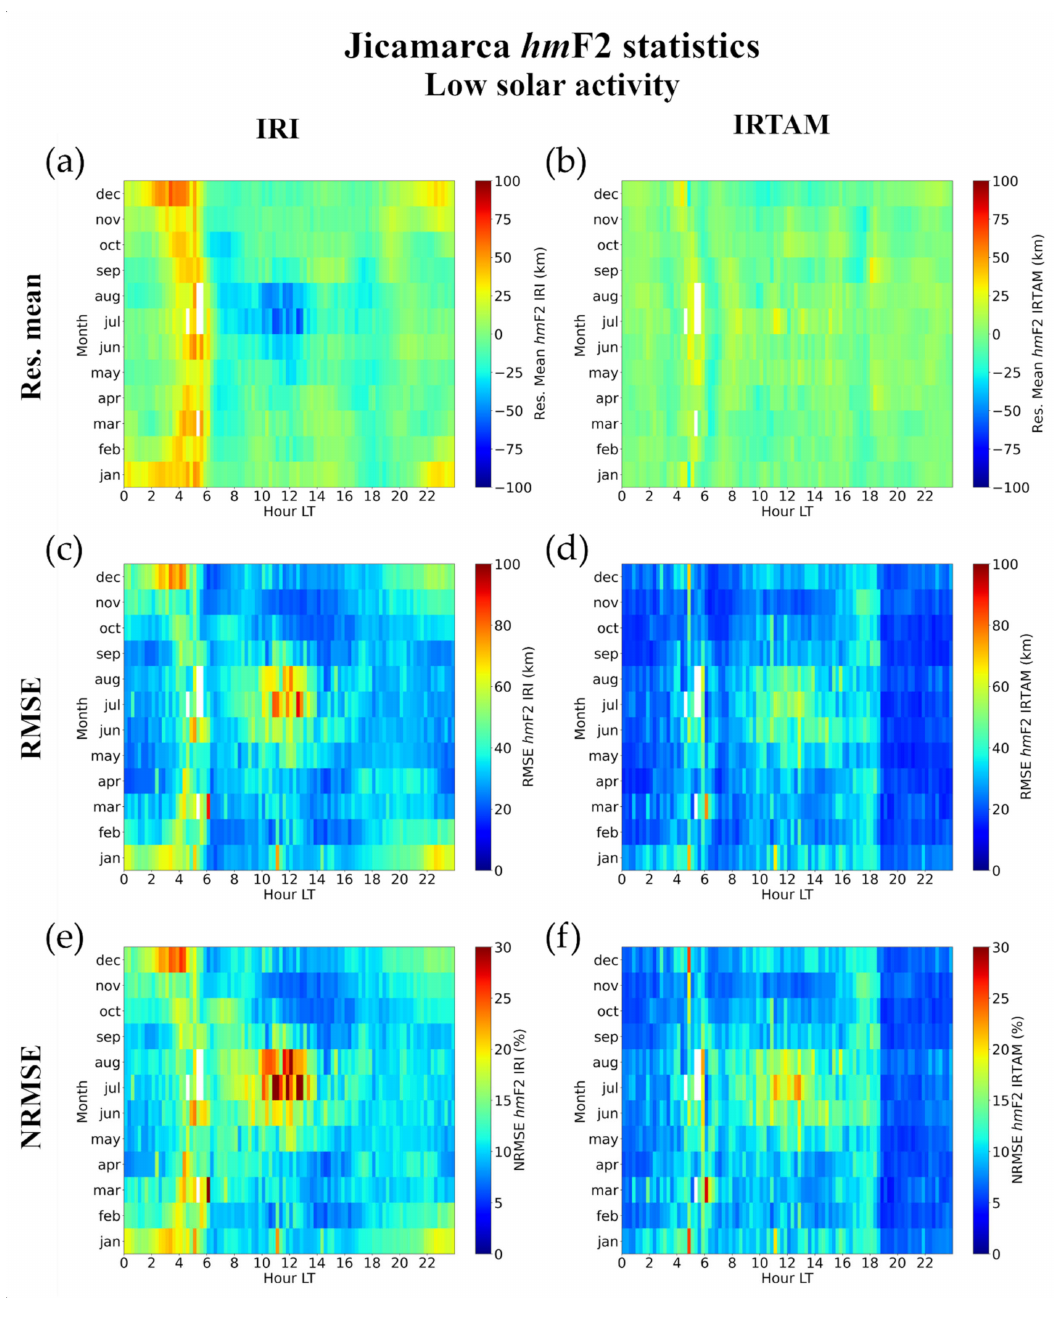
Figure 25. Grids of ( a , b ) Res. Mean , ( c , d ) RMSE , and ( e , f ) NRMSE values calculated between hm F2 values modeled by ( a , c , e ) IRI and ( b , d , f ) IRTAM, and those measured by the Jicamarca ionosonde for LSA. Monthly values ( y -axis) are binned in fifteen minute-wide bins in LT ( x -axis). The white color highlights bins with less than ten counts for which values were not calculated because considered not statistically